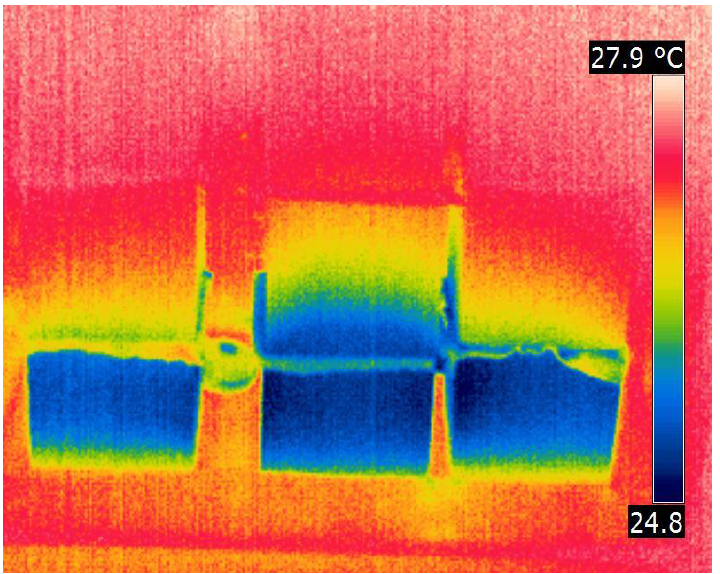
Figure A2. Thermographic report dated September 28, 2018, for Carparo (C.), Lecce stone (L.S.), and Tuff (T.).